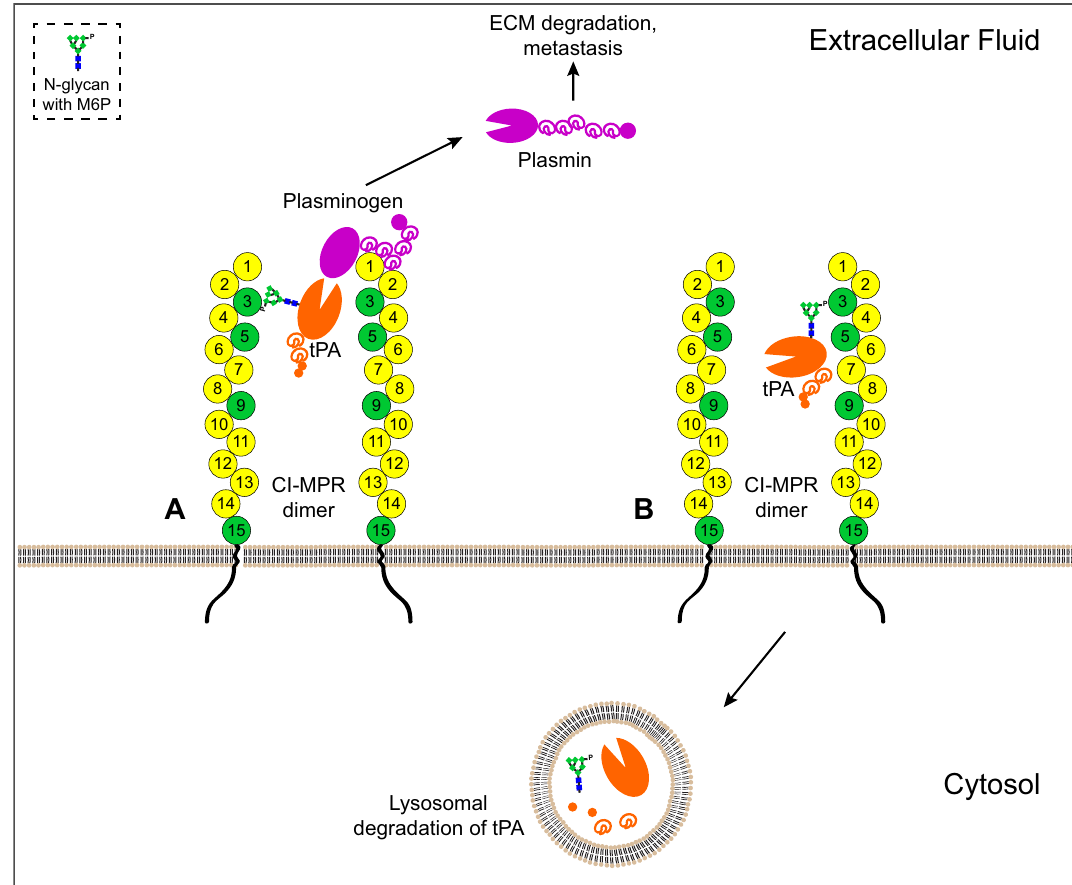
Figure 9. Models of possible biological significance of CI-MPR and tPA binding. CI-MPR domains that can bind M6P and/or M6P-GlcNAc are represented in green circles, while all other domains are represented in yellow circles. ( A ) CI-MPR may serve as a scaffold to bring tPA and plasminogen in close proximity to one another, which may facilitate plasmin generation. Active plasmin can degrade ECM and enable cancer cell metastasis. ( B ) Similar to M6P-containing lysosomal enzymes, the M6P or M6P-GlcNAc binding sites of CI-MPR may sequester tPA, thereby targeting tPA to the lysosome for degradation. In this model, tPA is shown bound to CI-MPR domain 3, but it is possible that tPA may bind to CI-MPR via its other carbohydrate recognition domains: domain 5, domain 9, or domain 15. CI-MPR cation-independent mannose 6-phosphate receptor, tPA tissue plasminogen activator, M6P mannose 6-phosphate, GlcNAc N -acetylglucosamine, ECM extracellular